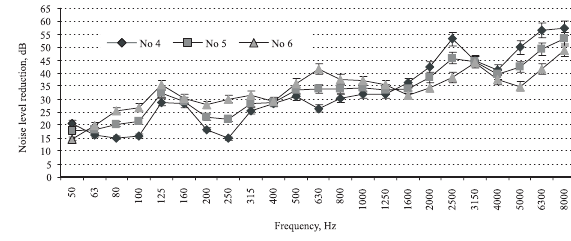
Fig. 3. Impact of No 4, No 5 and No 6 samples of experimental structures (Table 1) on noise suppression efficiency